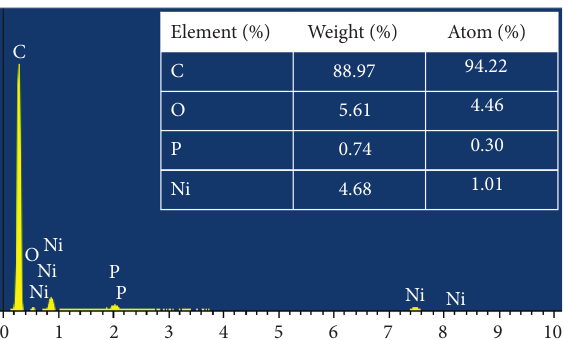
Figure 5: EDS spectra and element content analysis table of Ni